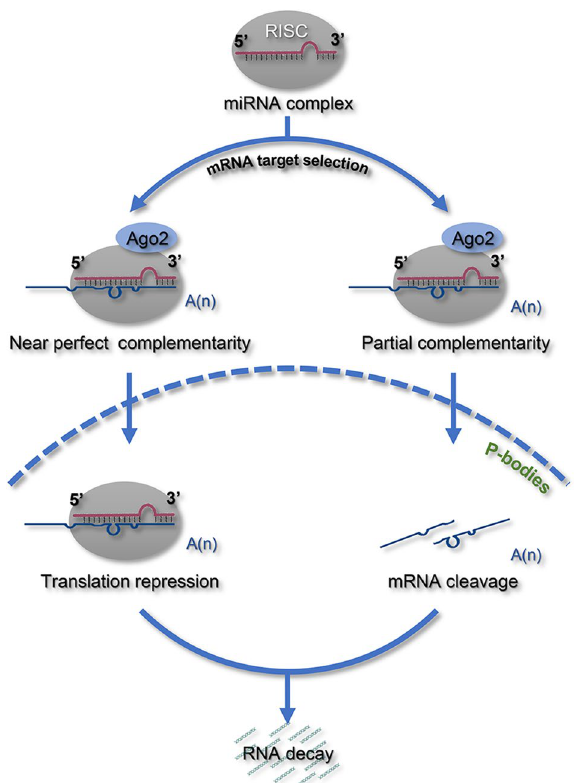
Fig. 2 Schematic diagram of miRNA-mediated translational repression. In RISC, miRNA-mediated downregulation of target gene activity occurs via two modes: target mRNA cleavage or translational inhibition. The choice is made based on the degree of complementarity between the miRNA and target gene in combination with an Argonaute family protein. Near-perfect complementarity results in cleavage, followed by general RNA degradation of the targets, whereas partial complementarity causes translational inhibition. miRNA-targeted mRNAs can be sequestered on polysomes or recruited to P-bodies where they are depleted of the translation machinery and eventually